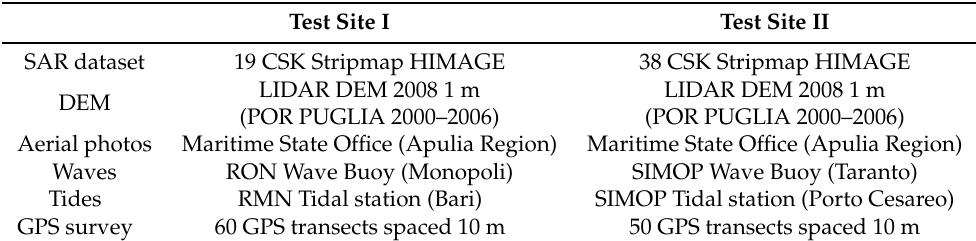
Table 1. Remote sensed and field data selected for the experimental analysis over the two test sites.